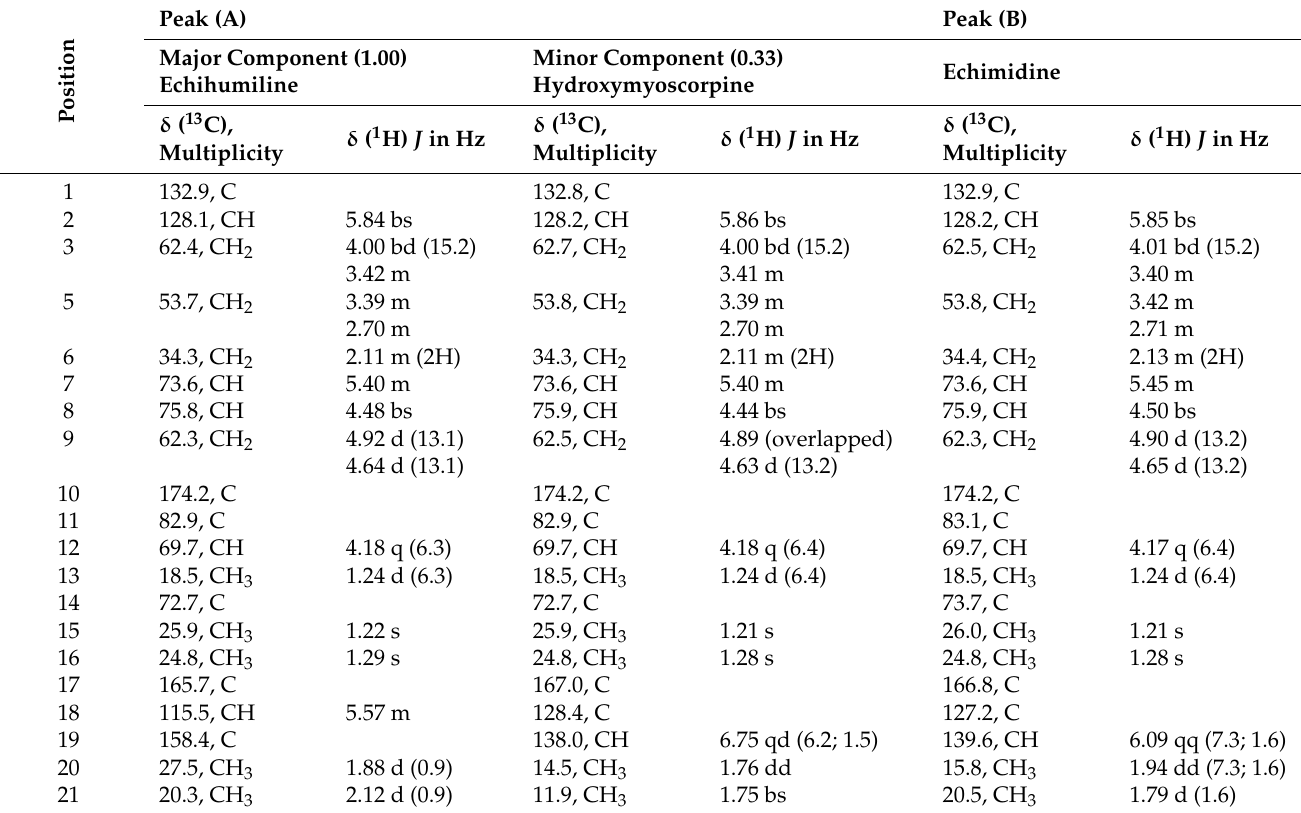
Table 1. NMR data for echihumiline, hydroxymyoscorpine and echimidine (CDCl 3 , 500 MHz, T = 295